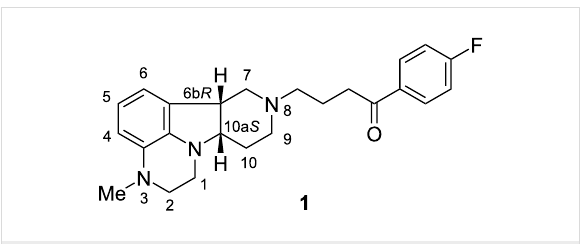
Figure 1: Structure of